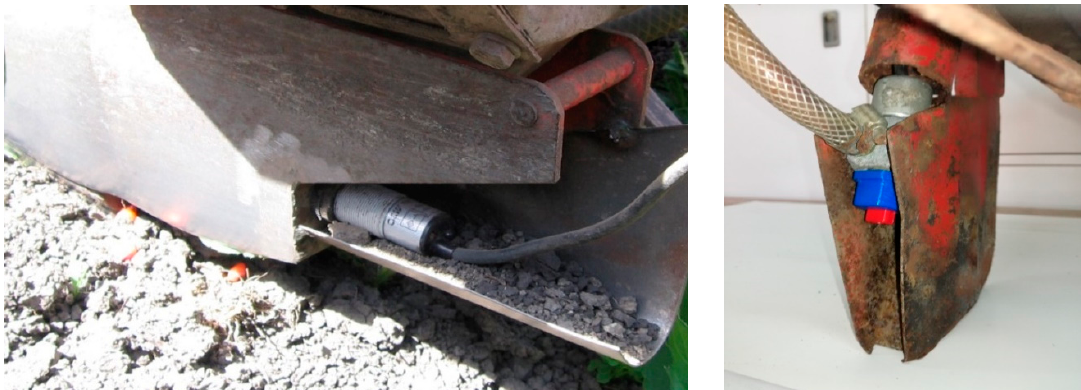
Figure 4. Photo electric sensor and the electric injector (Source: Original).